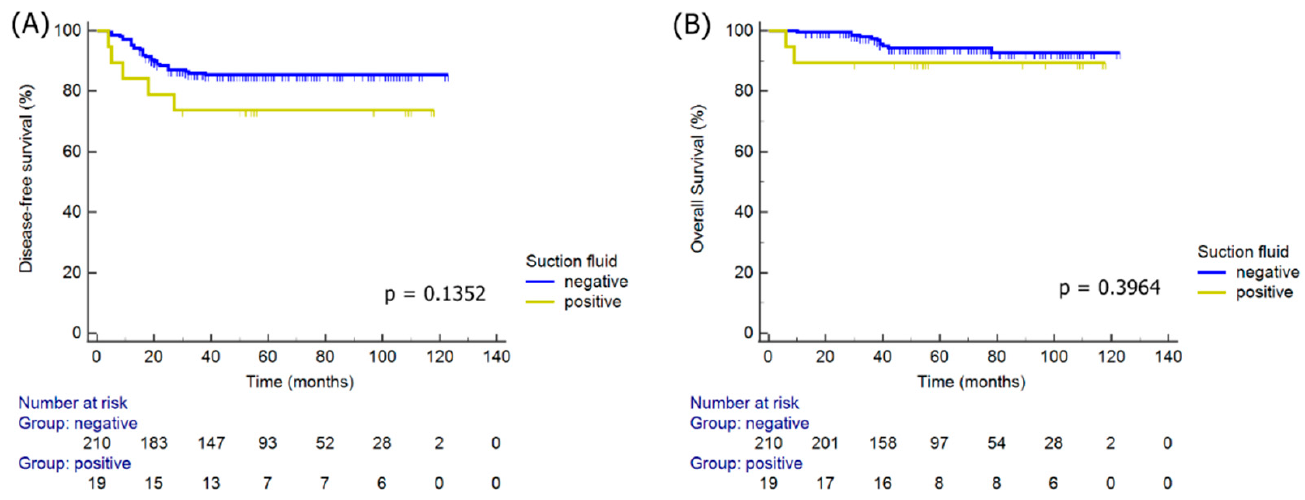
Figure 2. Kaplan–Meier survival plots for disease-free survival ( A ) and overall survival ( B ) based on residual cancer cells status.